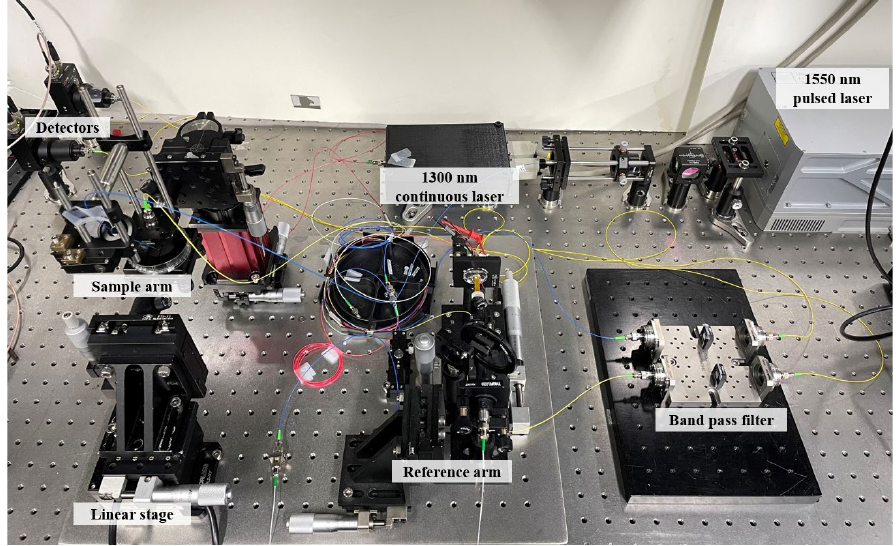
Figure 6. The photograph of developed all-optic LUS system. Both the excitation and the detection of acoustic waves are made with lasers.